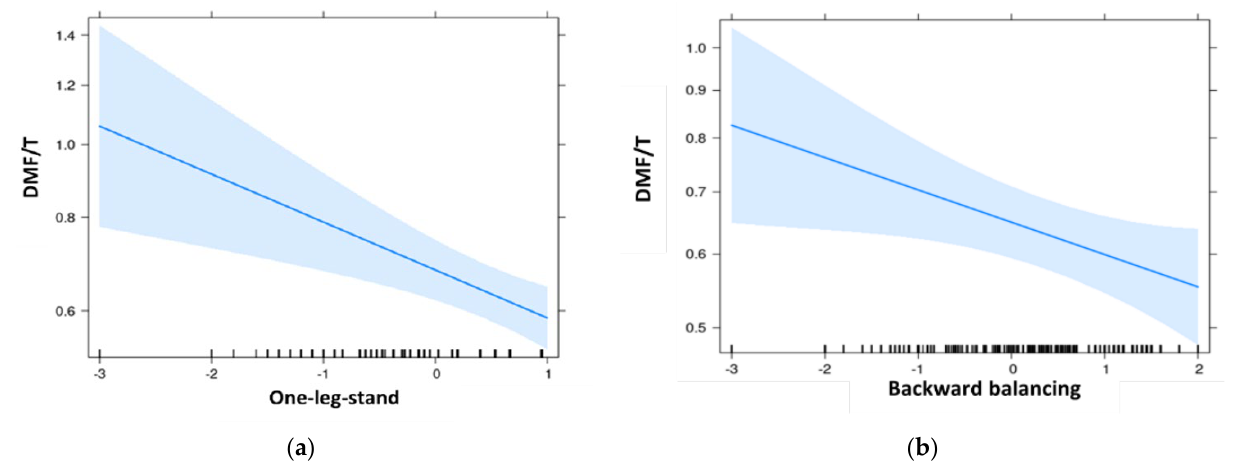
Figure 2. Effect plots of Poisson regression analysis of DMF/T and coordination skills in children and adolescents of 10 to 18 years (Leipzig, Germany): ( a ) of the backward balancing test; ( b ) of the one-leg-stand test.